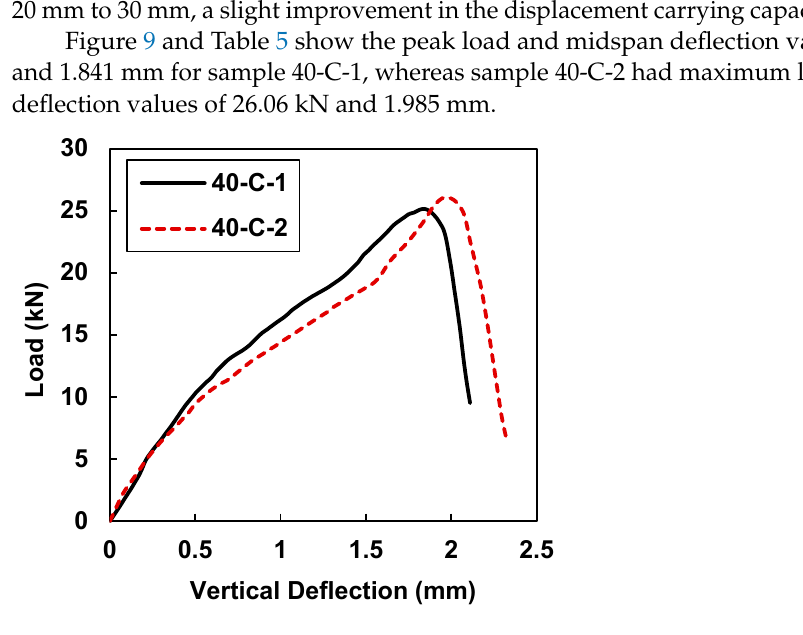
Figure 9. Load vs. midspan deflection for samples 40-C-1 and 40-C-2.